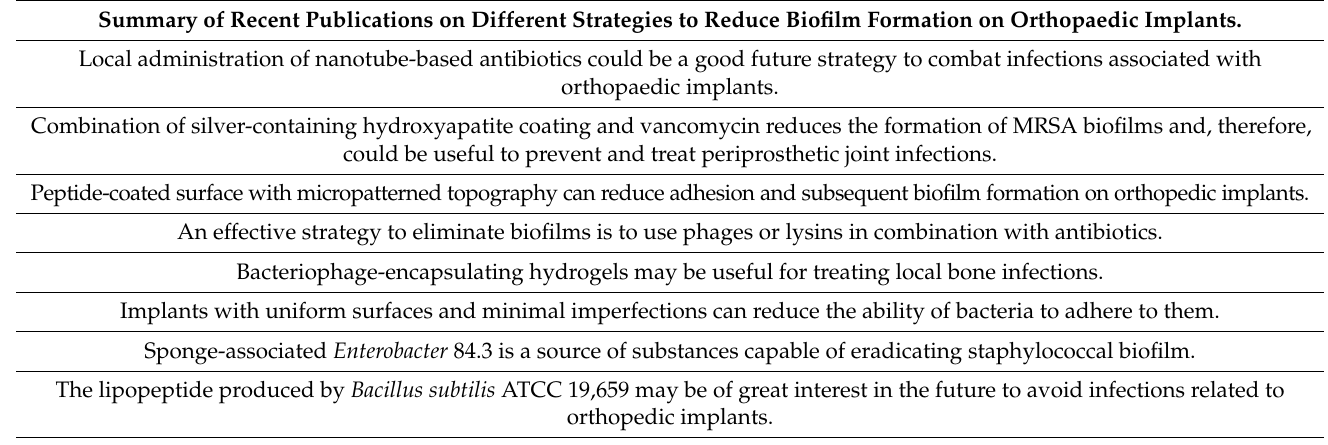
Table 2. Summary of recent publications on different strategies to reduce biofilm formation on orthopaedic implants. Summary of Recent Publications on Different Strategies to Reduce Biofilm Formation on Orthopaedic Implants. Local administration of nanotube-based antibiotics could be a good future strategy to combat infections associated with orthopaedic